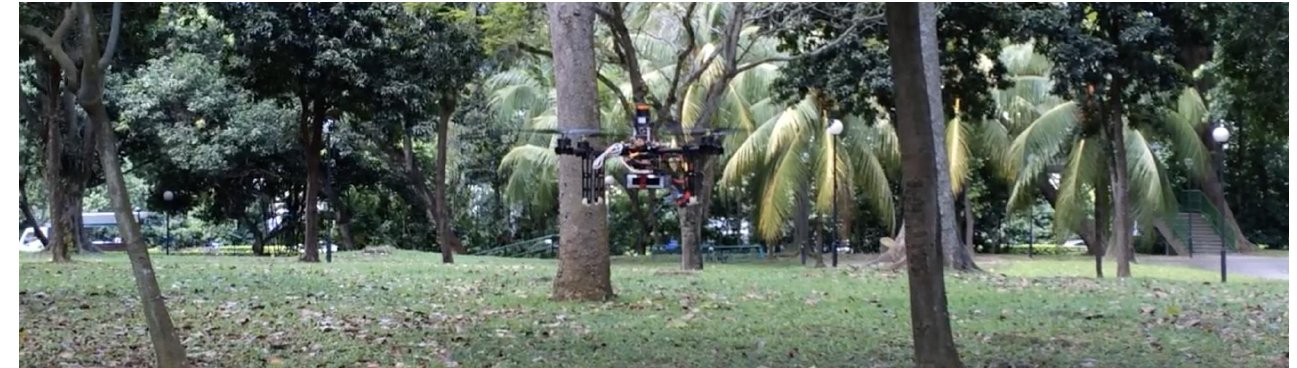
Figure 1. A view of the study area with the UAV in flight.